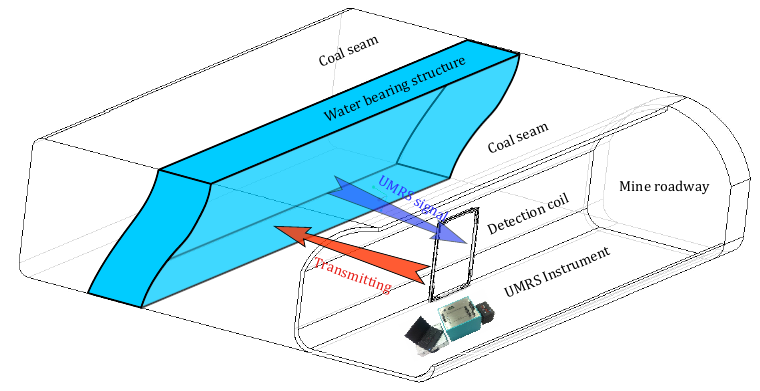
Figure 1. Principle diagram of underground magnetic resonance sounding (UMRS) detection